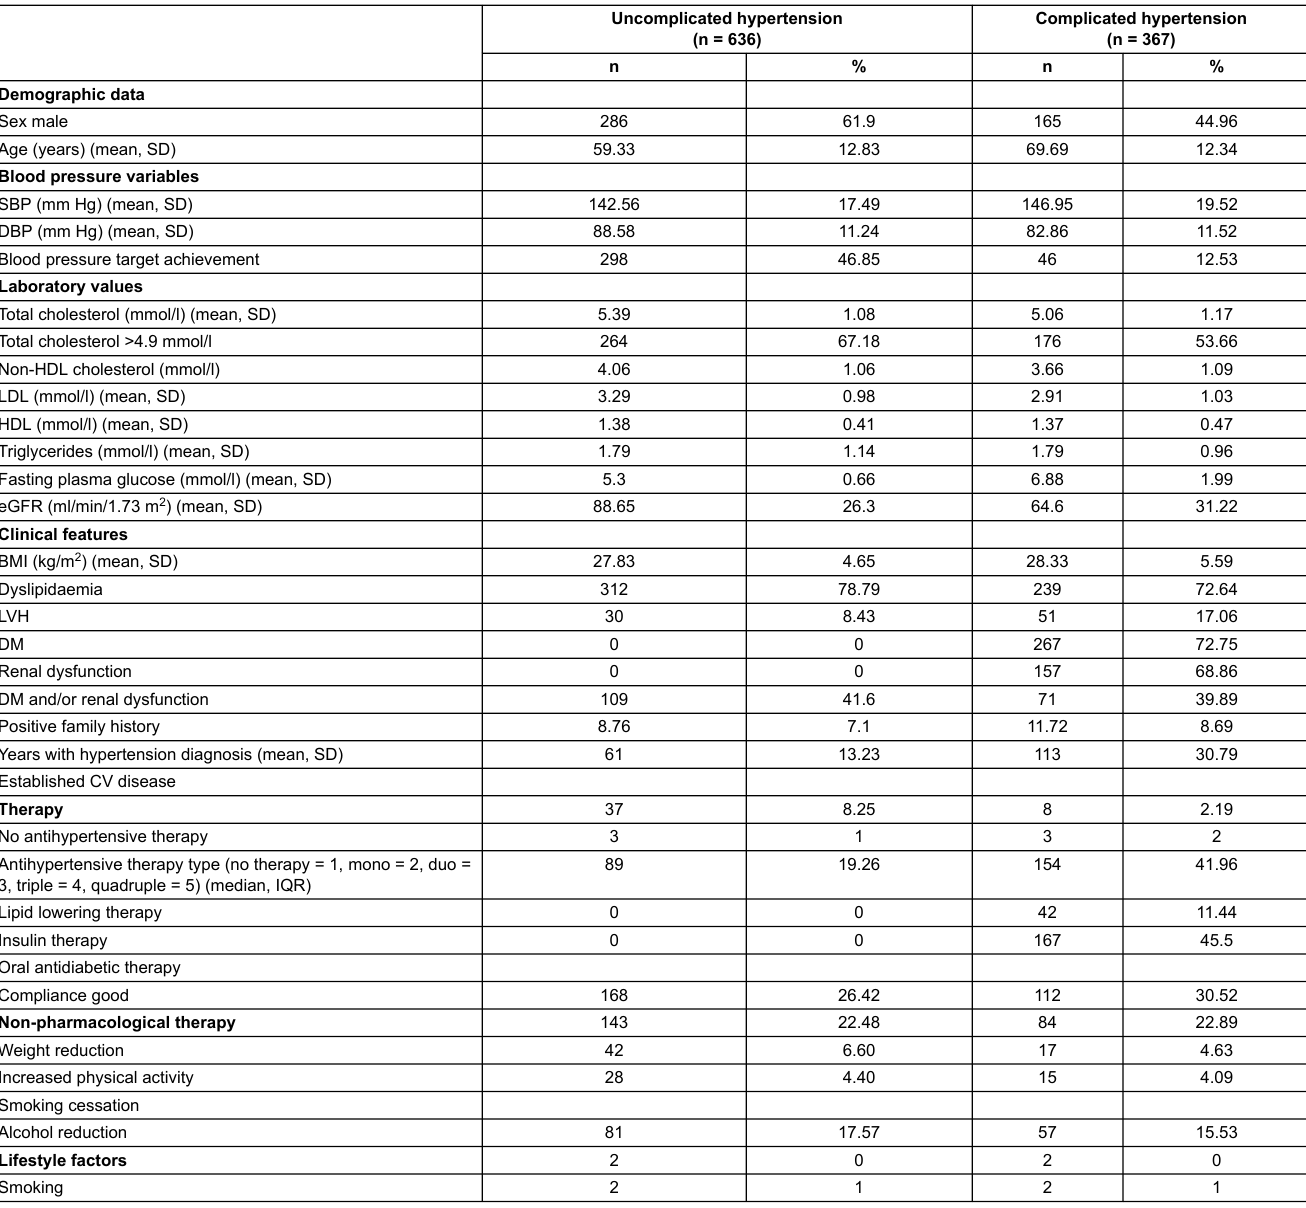
Table 2: Differences between the groups with complicated and uncomplicated hypertension at